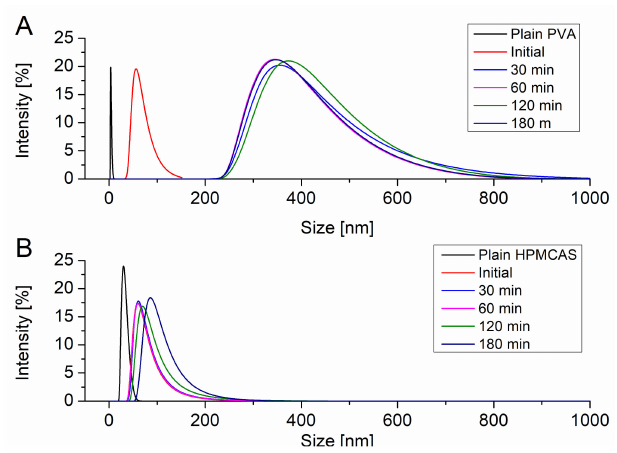
Figure 3. Evolution of the particle size upon supersaturation in presence of PVA ( A ) and HPMCAS ( B ).